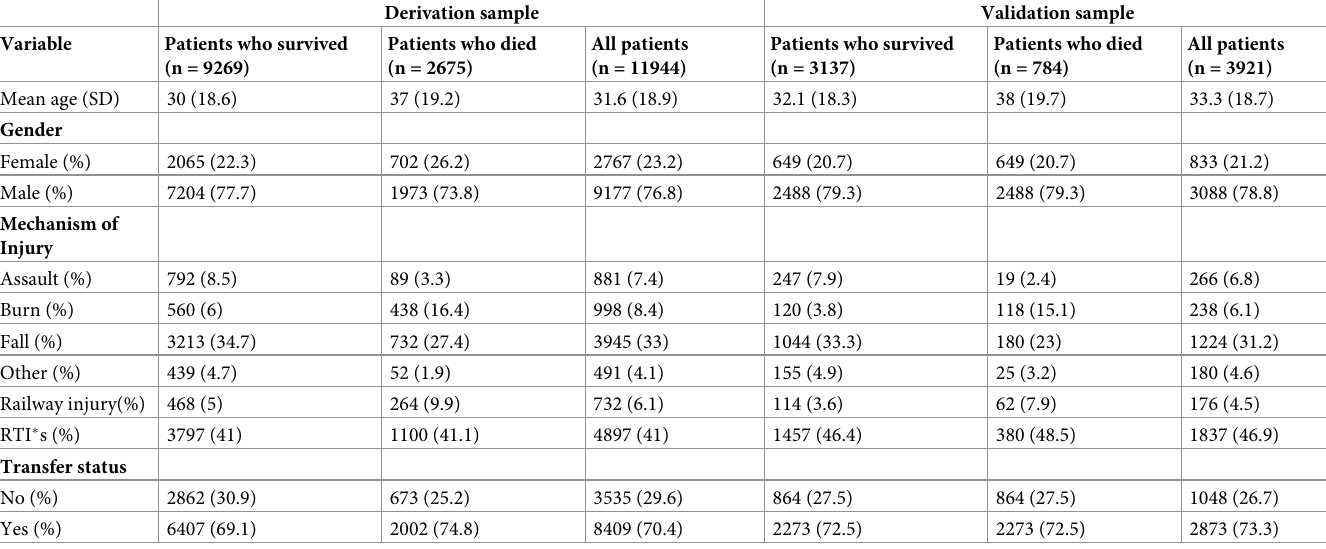
Table 2. Patient characteristics.